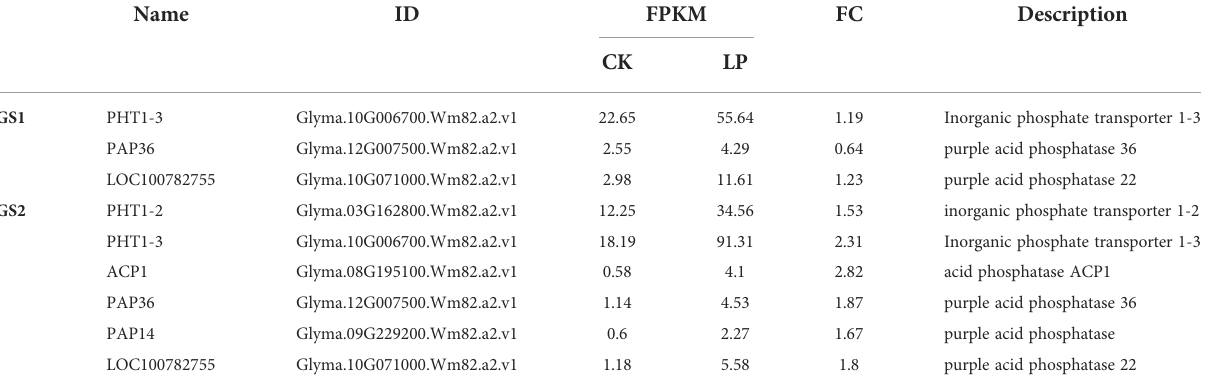
TABLE 2 The expression of typical LP stress induced genes of DEGs in roots of two ecotypes wild soybean seedlings under LP.